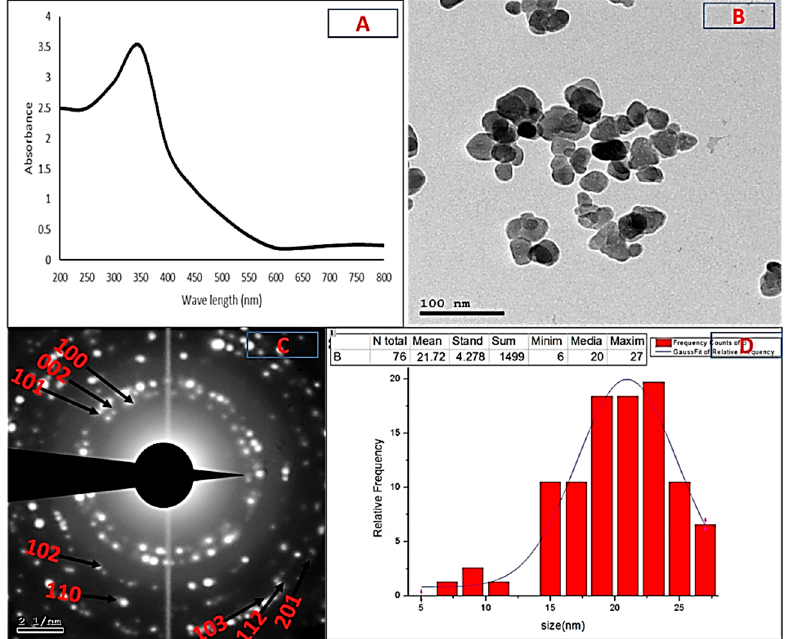
Figure 2. UV ‐ visible absorption bands of ZnO ‐ NPs synthesized from isolate MK ‐ 104 ( A ); trans ‐ mission electron microscopic image of ZnO ‐ NPs ( B ); SAED pattern of ZnO ‐ NPs ( C ); chart of av ‐ electron microscopic image of ZnO-NPs ( B ); SAED pattern of ZnO-NPs ( C ); chart of average size erage size determination ( D ). determination ( D